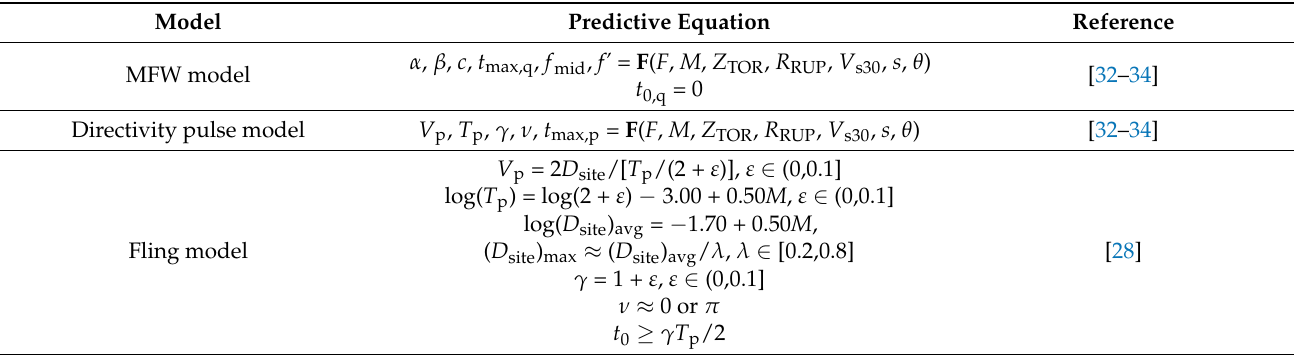
Table 1. Predictive equations for the input parameters.